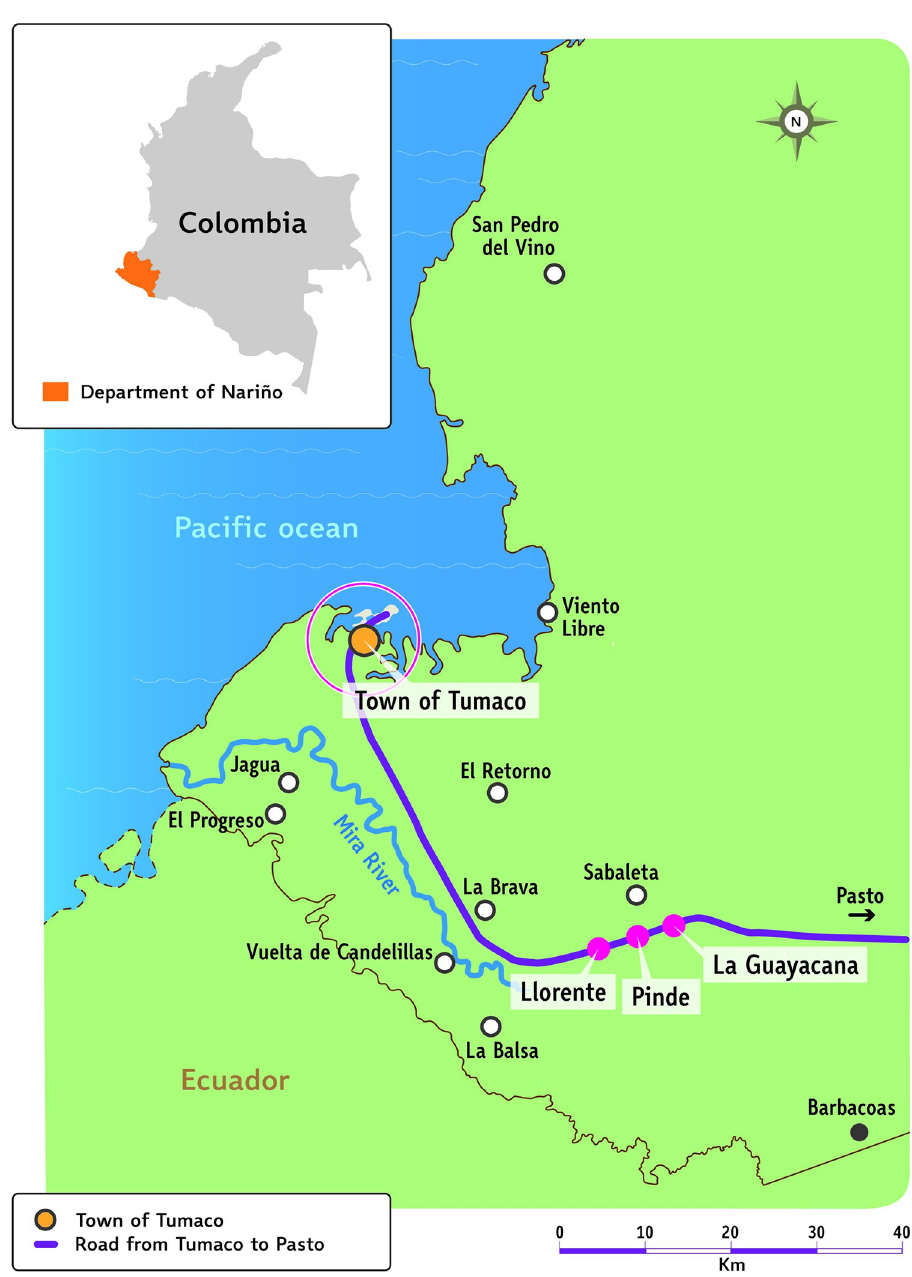
Fig 2. Study area. Tumaco municipality. The CIDEIM facility is in Tumaco town. During the study, participants had to reside in, or have access to, one of the three veredas shown as pink dots. Other names are of selected places of permanent residence of study participants. The international boundary is available from the GADM database of global administrative areas (https://gadm.org/download_country.html) under the licence shown at https://gadm.org/license. html. Locations were approximated from a map made by the United Nations Office for the Coordination of Humanitarian Affairs [26]. All are in Tumaco municipality except one (Barbacoas) shown as a solid black dot. with the mobile phone camera, and the Guaral +ST application. The CIDEIM health service team was also trained to support the CHV in the field work.